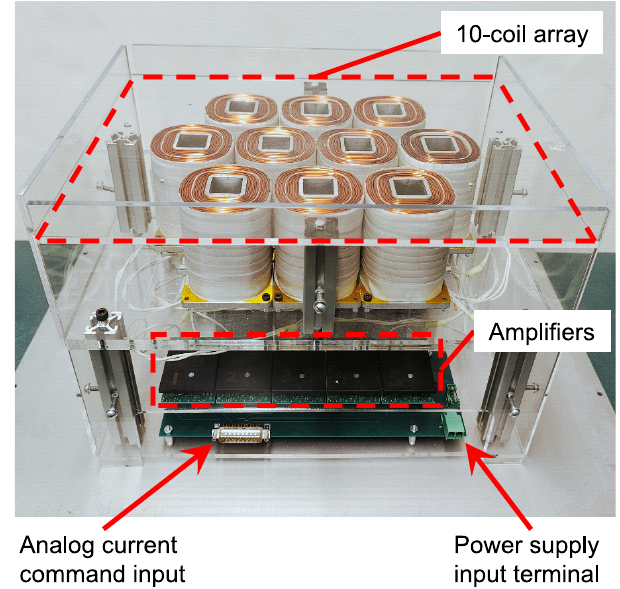
Figure 6. Compact planar maglev prototype structure.